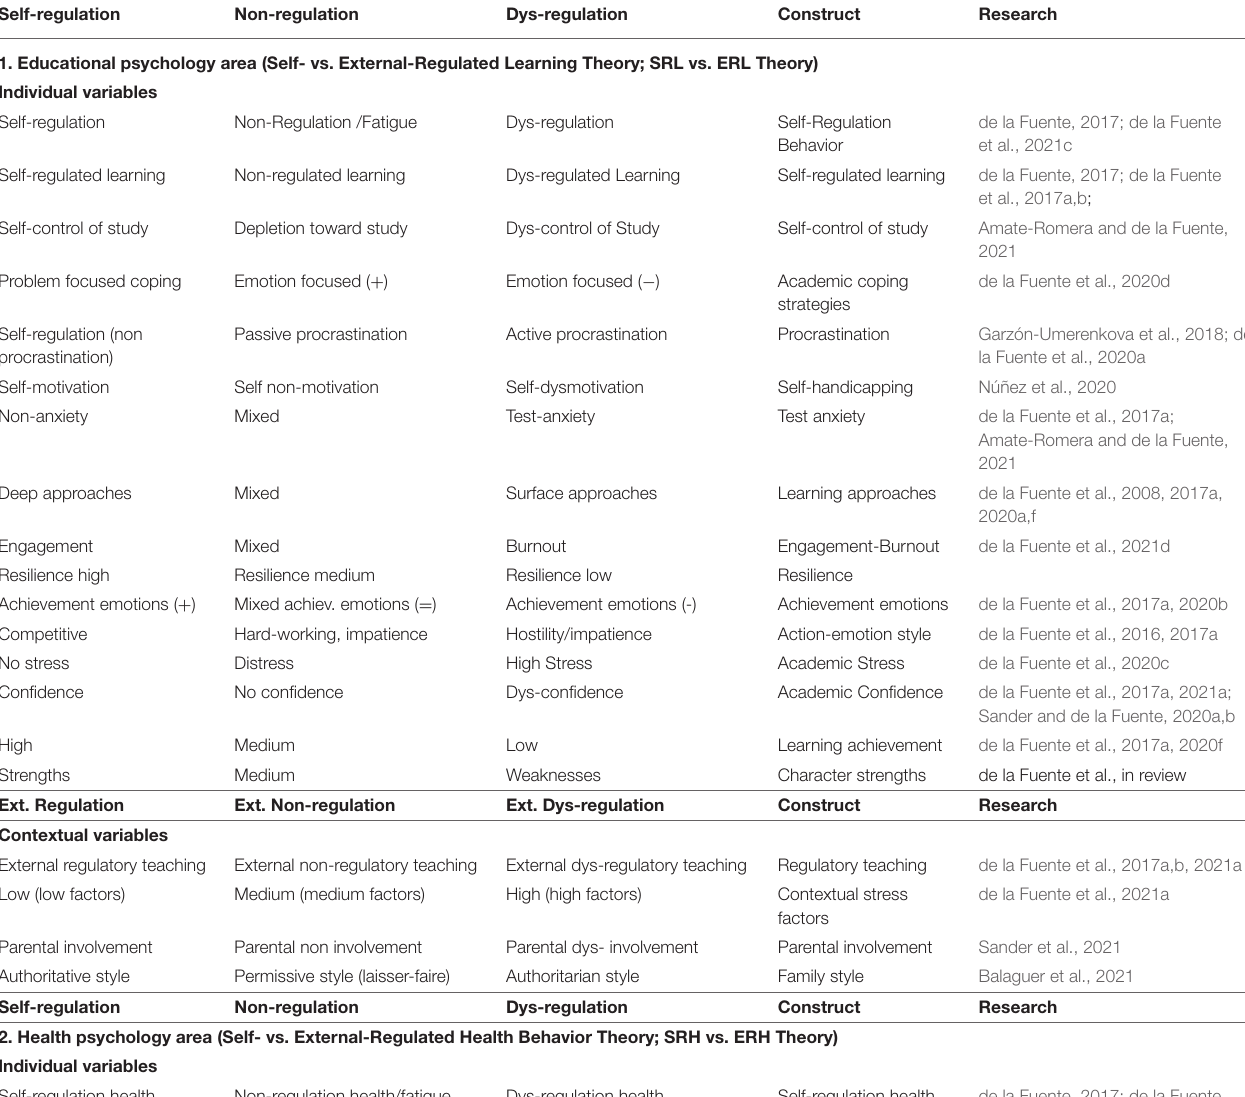
TABLE 3 | Summarized research agenda for Self- vs. External-Regulation Theory ( SR vs. ER Theory) , applied to different fields of the study of behavior in different